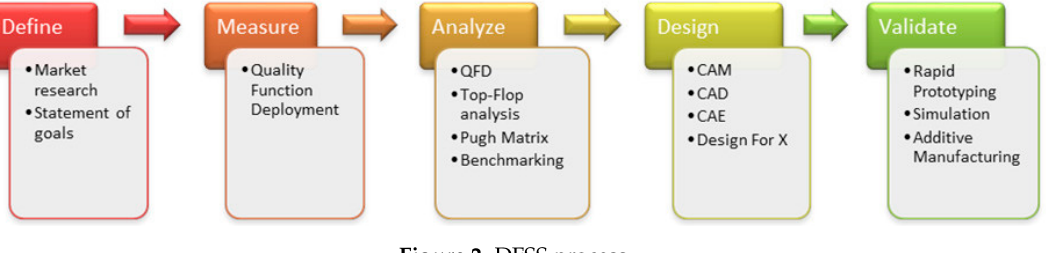
Figure 2. DFSS Figure 2. DFSS process.